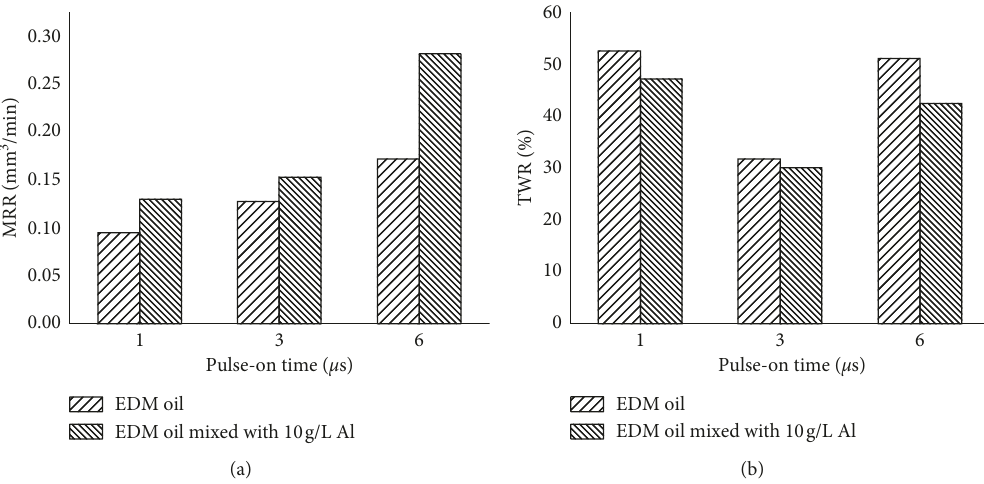
Figure 6: Influence of pulse-on time on the machining performance in different dielectric liquids.